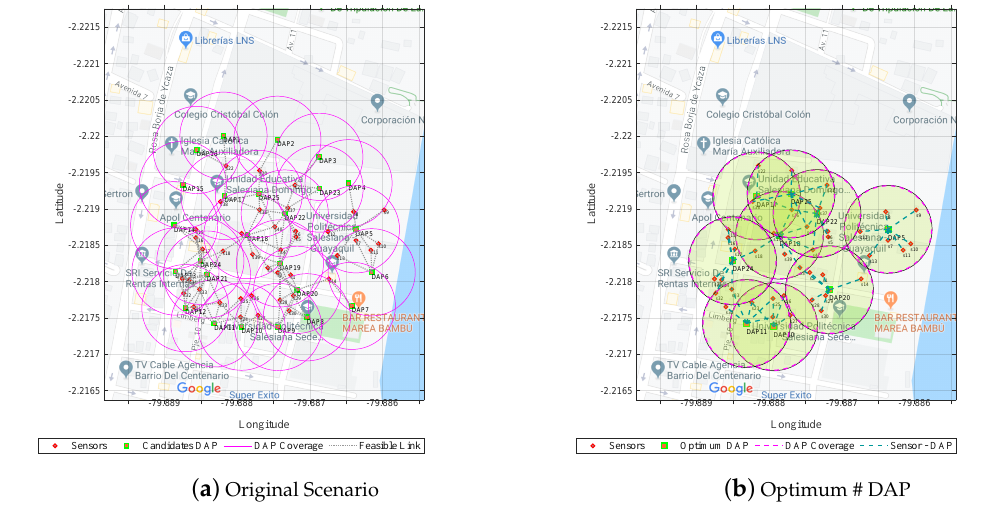
Figure 2. Minimization of the DAPs based on the sizing model. Figure 3 indicates the variations in power consumption among the wireless technolo- gies. It is remarkable to see that when opting for a single technology, such as a cellular network, energy consumption is higher than for technologies that have lower coverage but have a multi-hop option and lower energy consumption.